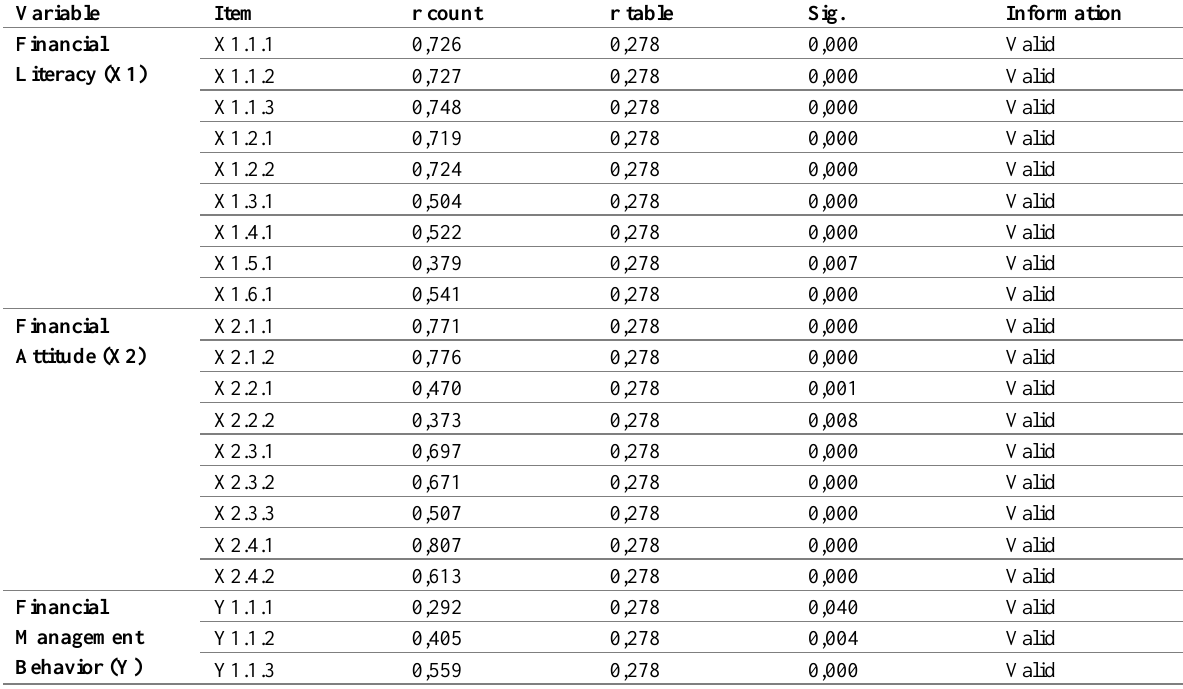
Table 5: Validity Test Result r